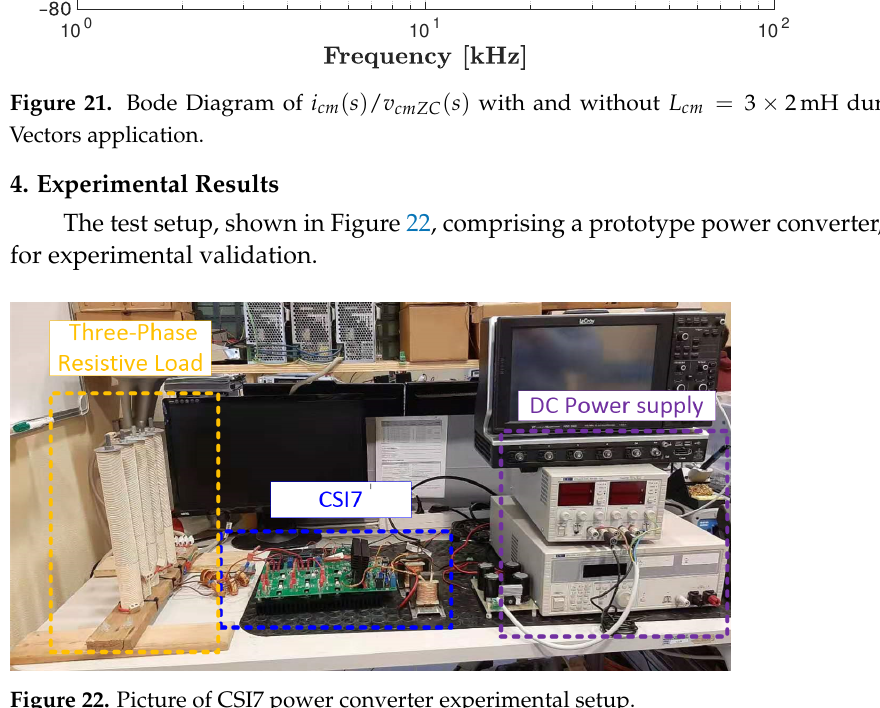
Figure 22. Picture of CSI7 power converter experimental setup.